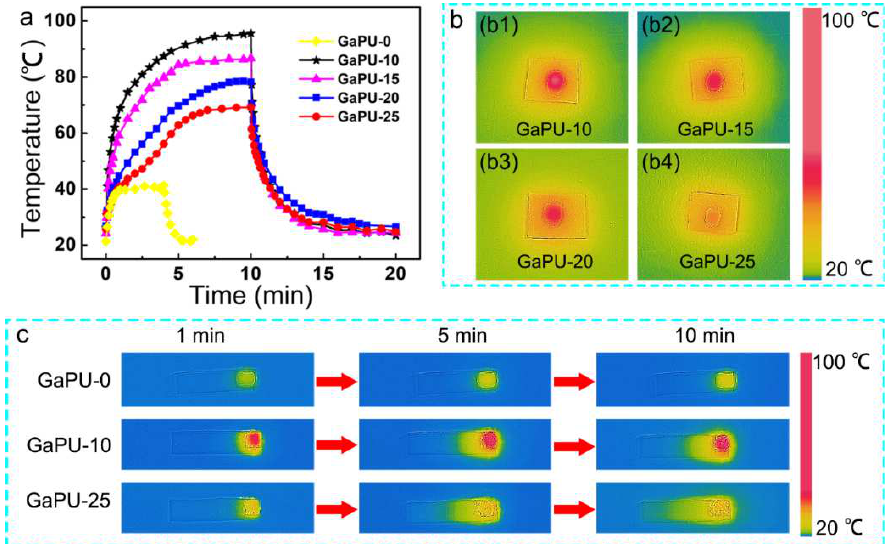
Figure 4. Photothermal effect of the Ga–PU composites. ( a ) The temperature as the function of time for the composite under NIR irradiation (2 W/cm 2 ). ( b ) Infrared thermal images for the composites with different vol% of Ga under NIR irradiation. ( c ) Heat transport under localized NIR irradiation.